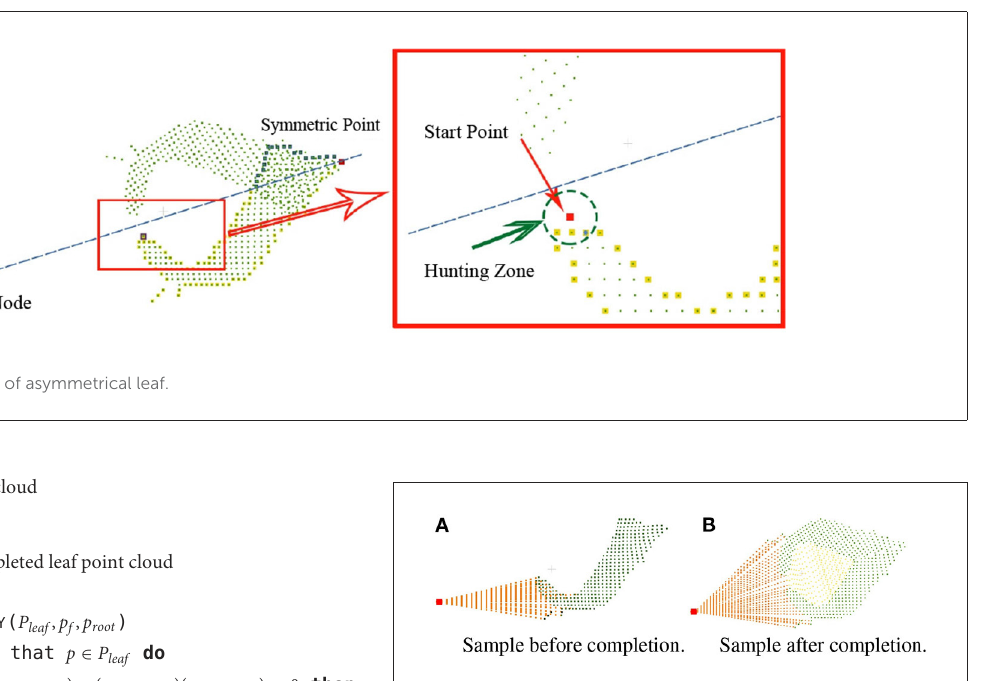
FIGURE7 Comparison of effect before and after completion. (A) Sample before completion. (B) Sample after